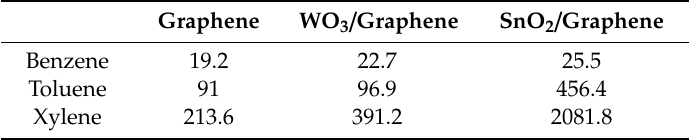
Table 1. Sensor sensitivity (10 − 2 × ppm − 1 ) for aromatic